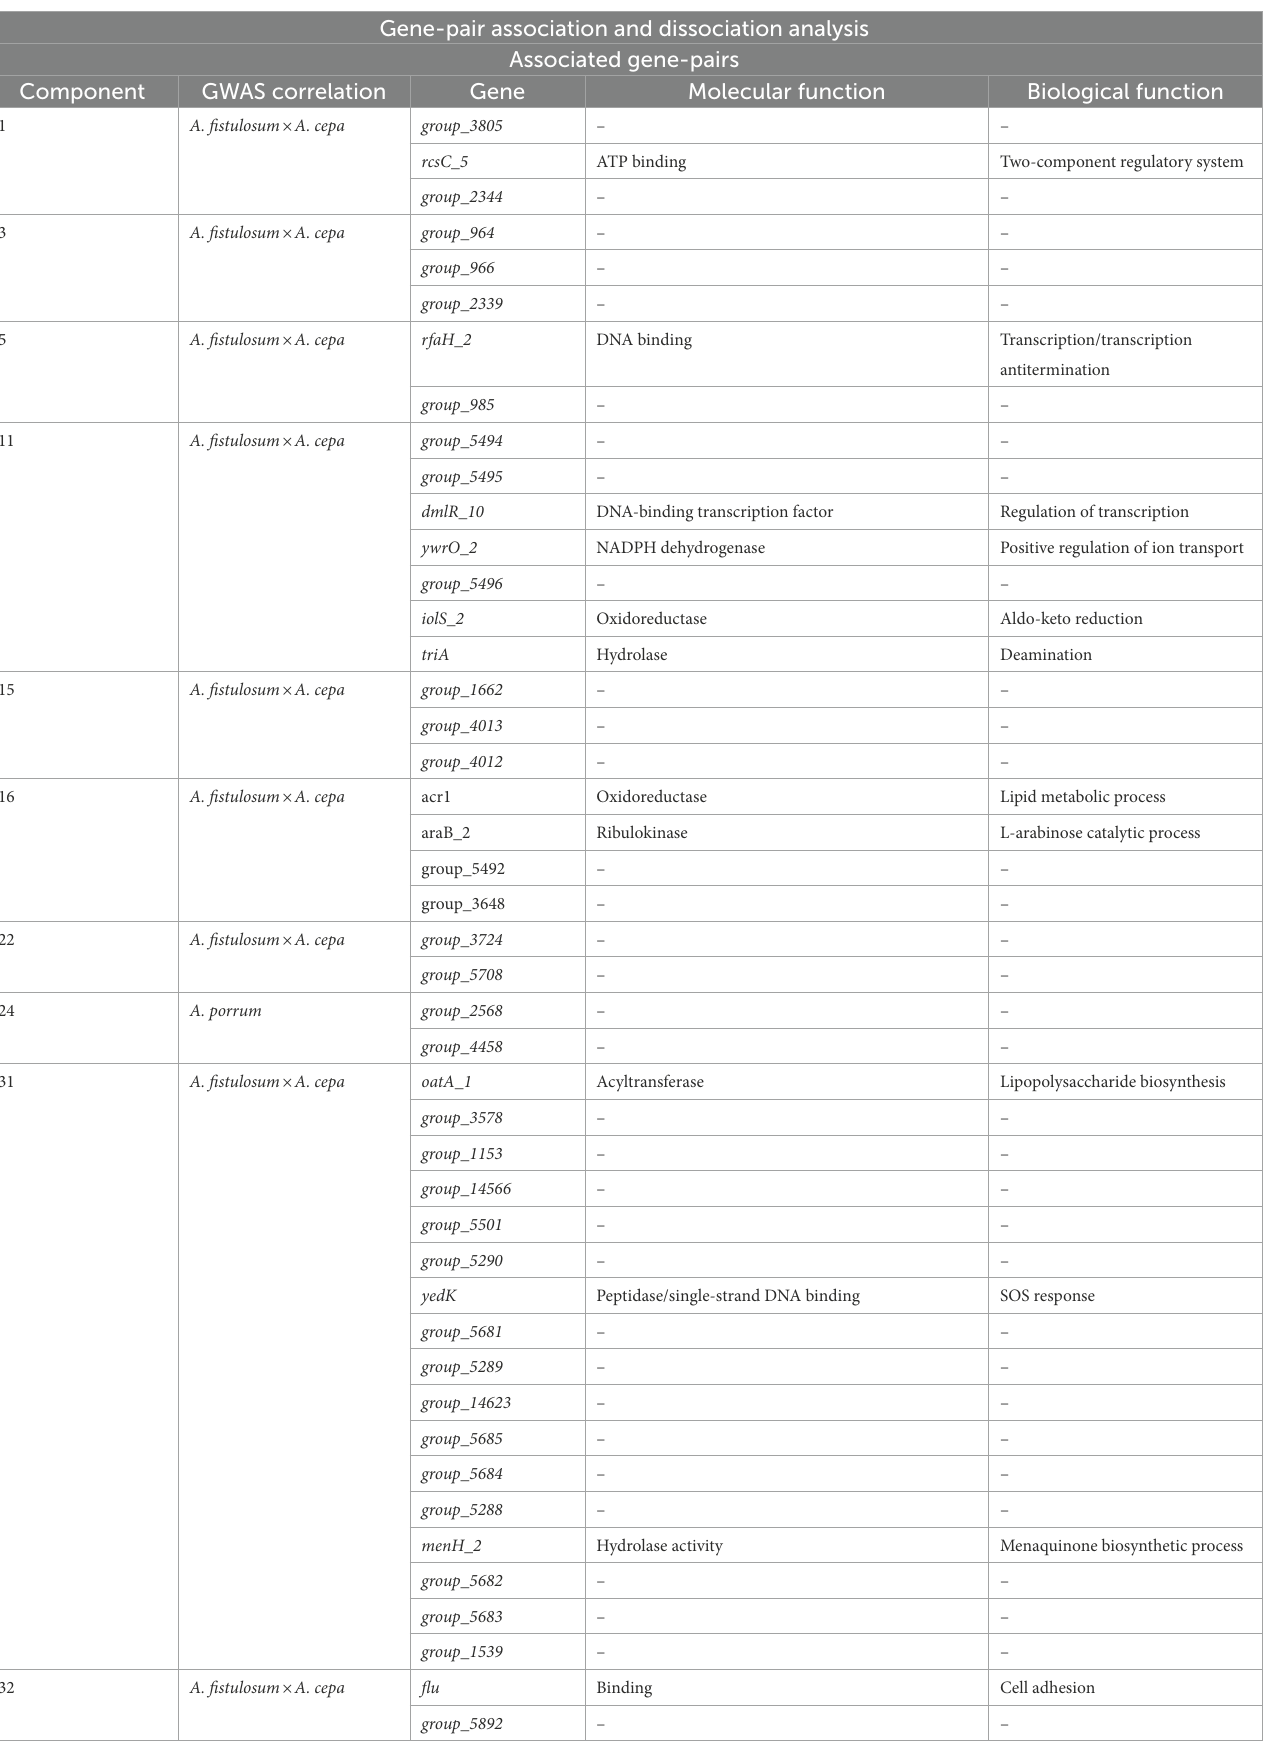
TABLE 2 List of gene-pair association components that contain genes shared with the predicted genes from the genome wise association studies (GWAS) results. Gene-pair association and dissociation analysis Associated gene-pairs Component GWAS correlation Gene Molecular function Biological